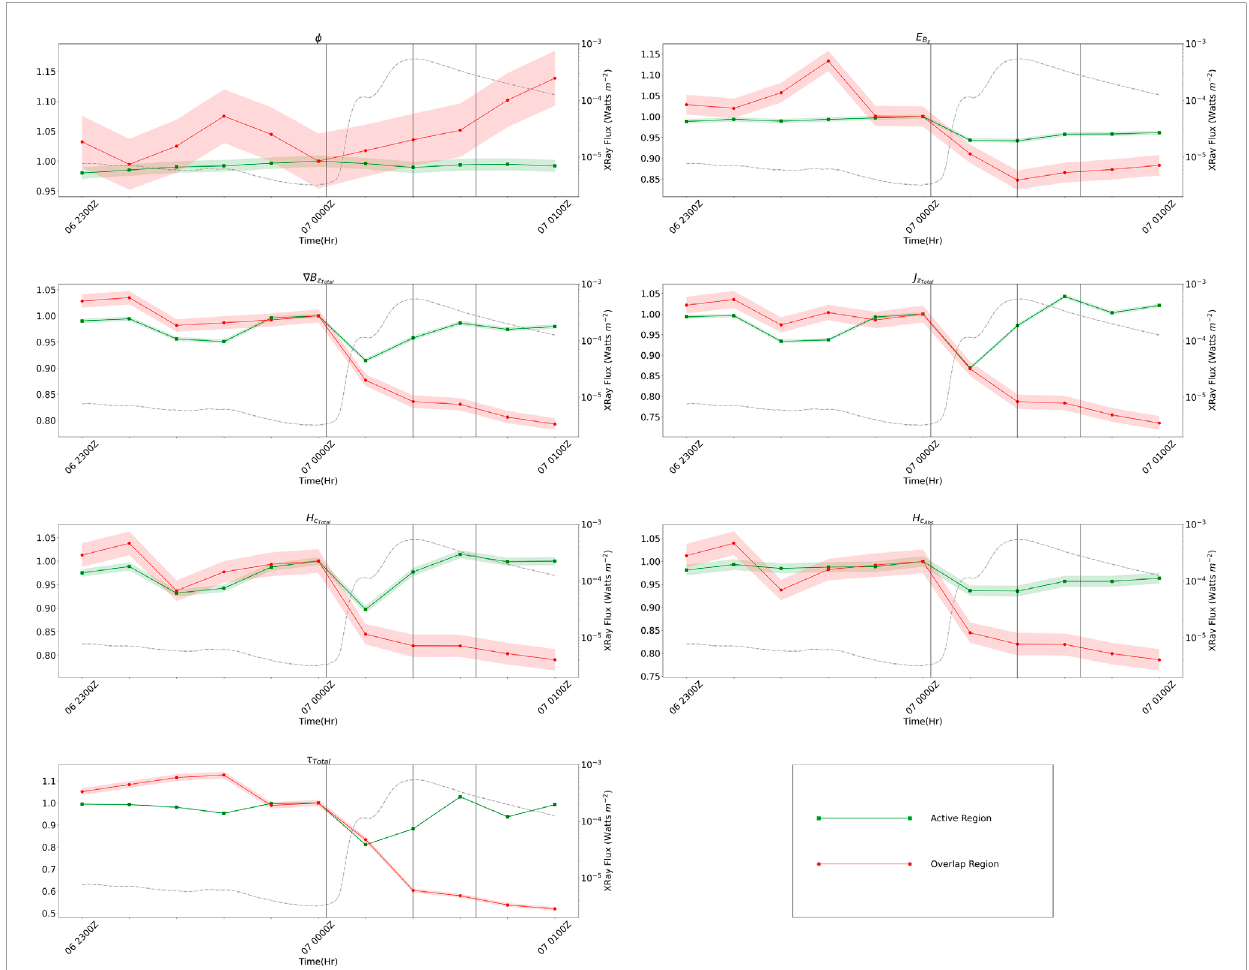
FIGURE 12 Time series of the seven magnetic field parameters calculated for each data volume, normalized to the values at the HARP data time closest to the start time of the X5.4 solar flare. The grey, dashed line is the GOES measured X-ray flux from the XRS long (1.0—8.0 Å) channel; the vertical, black dashed lines represent the GOES recorded start, max, and end time of the flare. The colored areas around the data points represent the error